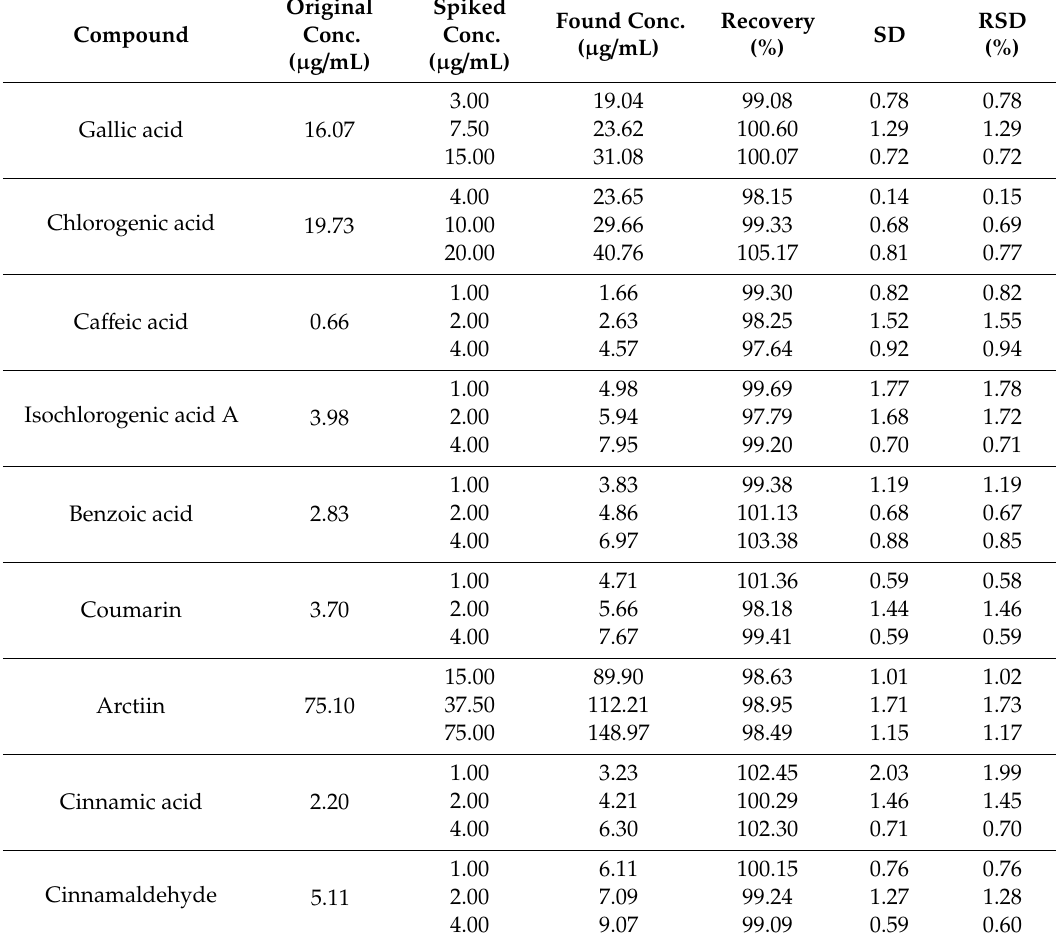
Table 3. Recovery test for the assay of 12 compounds in